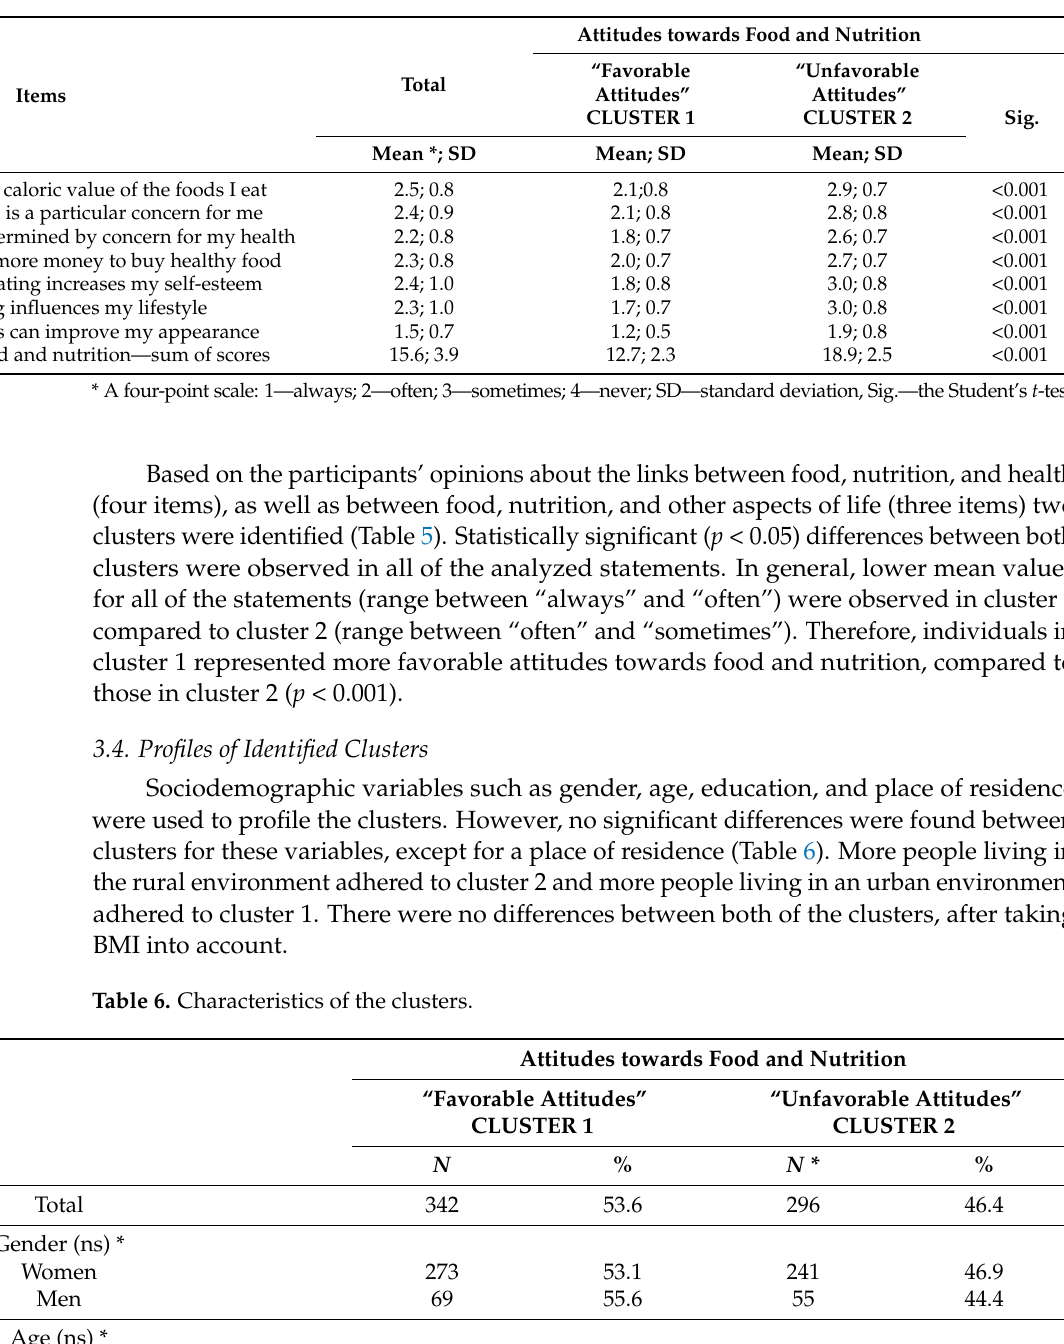
Table 5. Characteristics of the identified clusters according to the classification variables.